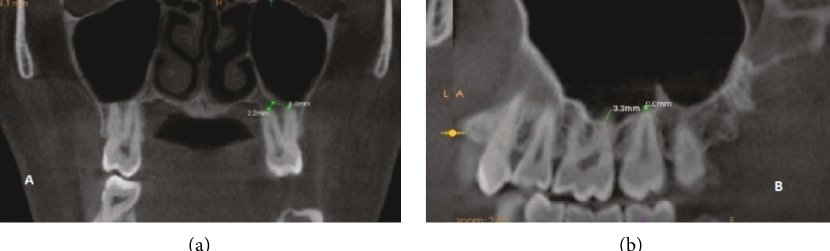
Figure 1: (a) Coronal section showing MB USM 2.2 from MSF and P USM contacting MSF. (b) Sagittal section of DB UFM 3.3MM from